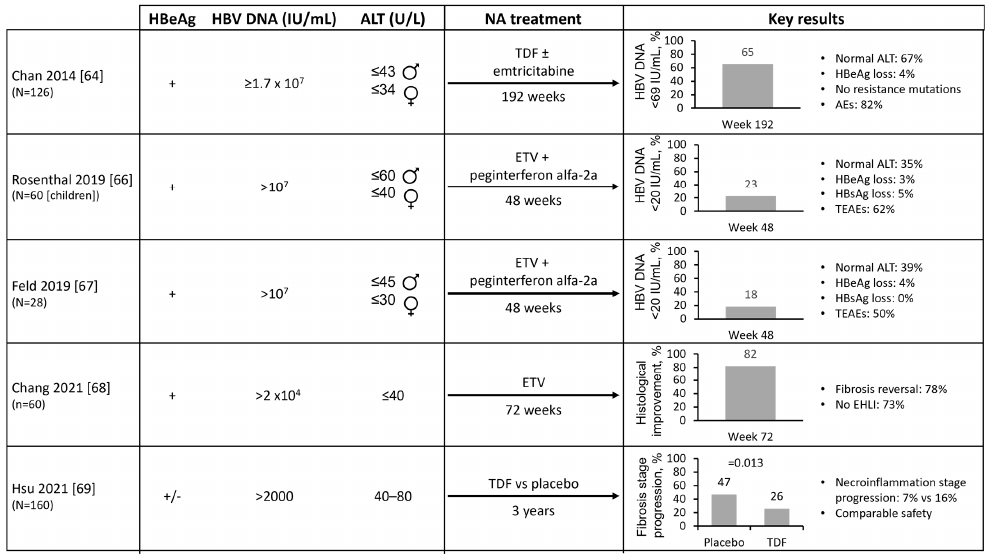
Figure 3. Impact of NA treatment on CHB clinical parameters in patients currently ineligible for antiviral treatment. This schematic summarizes the studies of NA treatment in CHB patients cur- rently ineligible for antiviral treatment including those in the HBeAg-positive chronic infection/im- mune-tolerant disease phase. Patient numbers are shown in brackets in the fi rst column. Patient baseline characteristics (HBeAg status and HBV DNA and ALT level) are shown in the second col- umn. NA treatment and duration are shown in the third column. Key e ffi cacy and safety results are shown in the fourth column. AE, adverse event; ALT, alanine aminotransferase; CHB, chronic hep- atitis B; EHLI, evident histological liver injury; ETV, entecavir; HBeAg, hepatitis B envelope antigen; HBsAg, hepatitis B surface antigen; HBV, hepatitis B virus; NA, nucleos(t)ide analog; TDF, tenofovir disoproxil; TEAE, treatment-emergent adverse event.